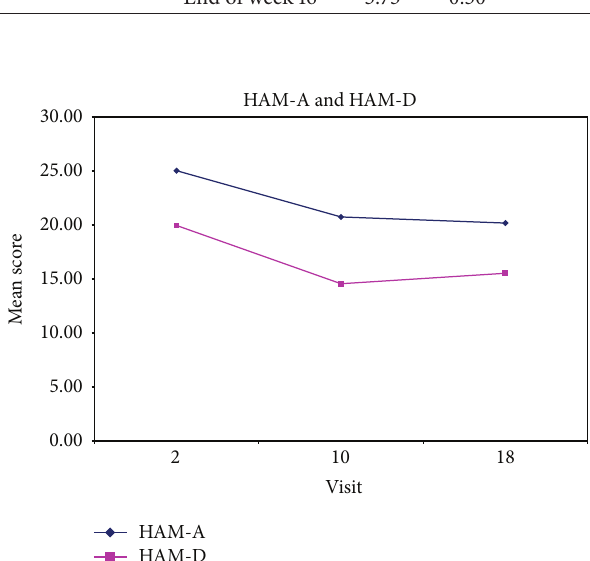
RBANS total score and subscales over time in both index scores and